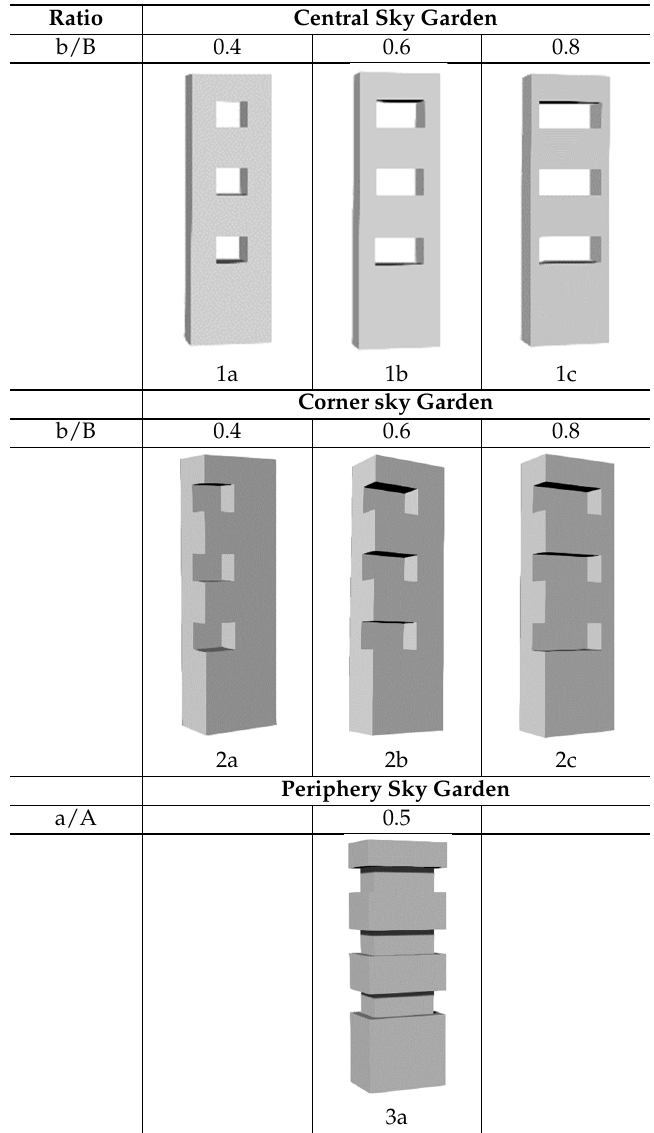
Table 2. Seven spatial configurations of sky garden designed and modelled in the study.